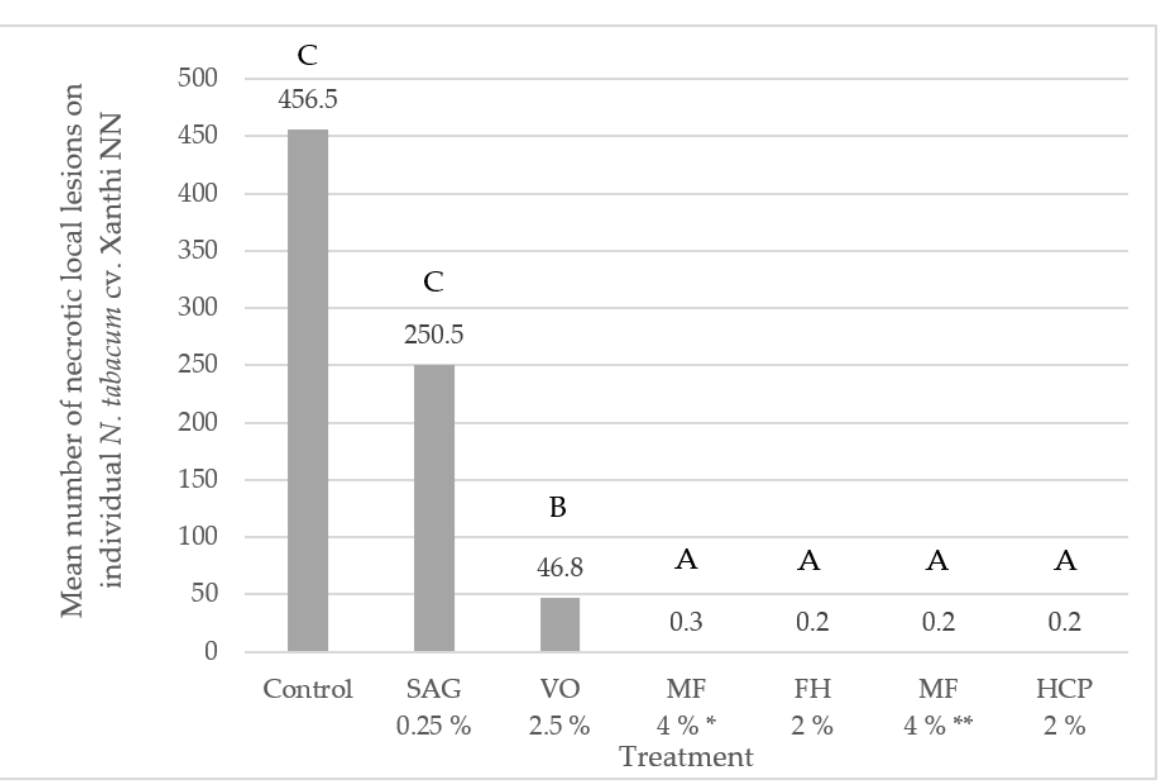
Figure 4. Evaluation of the cleaning efficacy of different products on Tomato brown rugose fruit virus - contaminated clothes by counting the number of necrotic local lesions on individual N. tabacum cv. Xanthi NN plants that were rub-inoculated with the treated (cleaned) cloth carriers. Letters based on pairwise treatment comparisons using generalized linear mixed model analysis of count data (alpha = 0.05, with Bonferroni correction). n = 24. ‘Control’ = Fabric contaminated with ToBRFV sap; ‘SAG’ = Spee Activ Gel; ‘VO’ = Vanish Oxi Action Gel; ‘MF’ = Menno Florades; ‘FH’ = Fadex H + ; ‘HCP’ = Hortisept Clean Plus. * 10 min contact time; ** 4 h contact time.